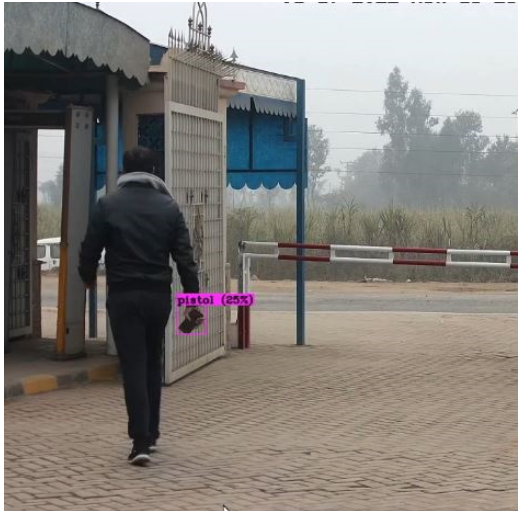
Figure 19. Misdetection results of Scaled-YOLOv4 in real-time CCTV stream.